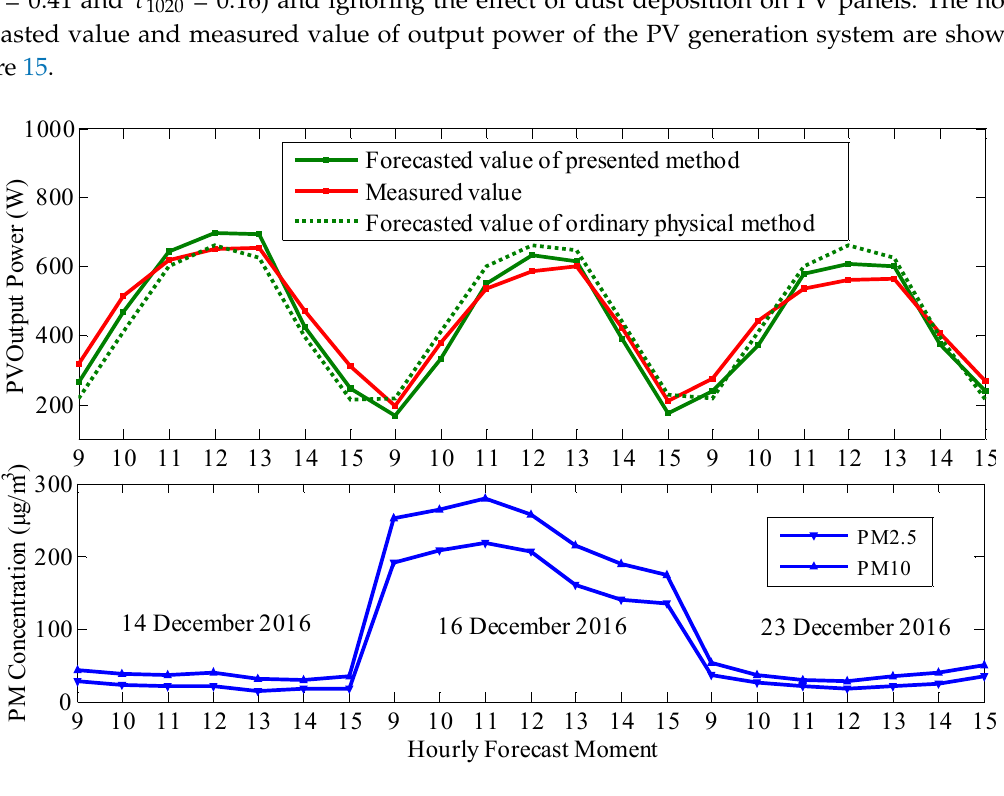
Figure 15. Hourly forecast result of output power of the PV generation system.